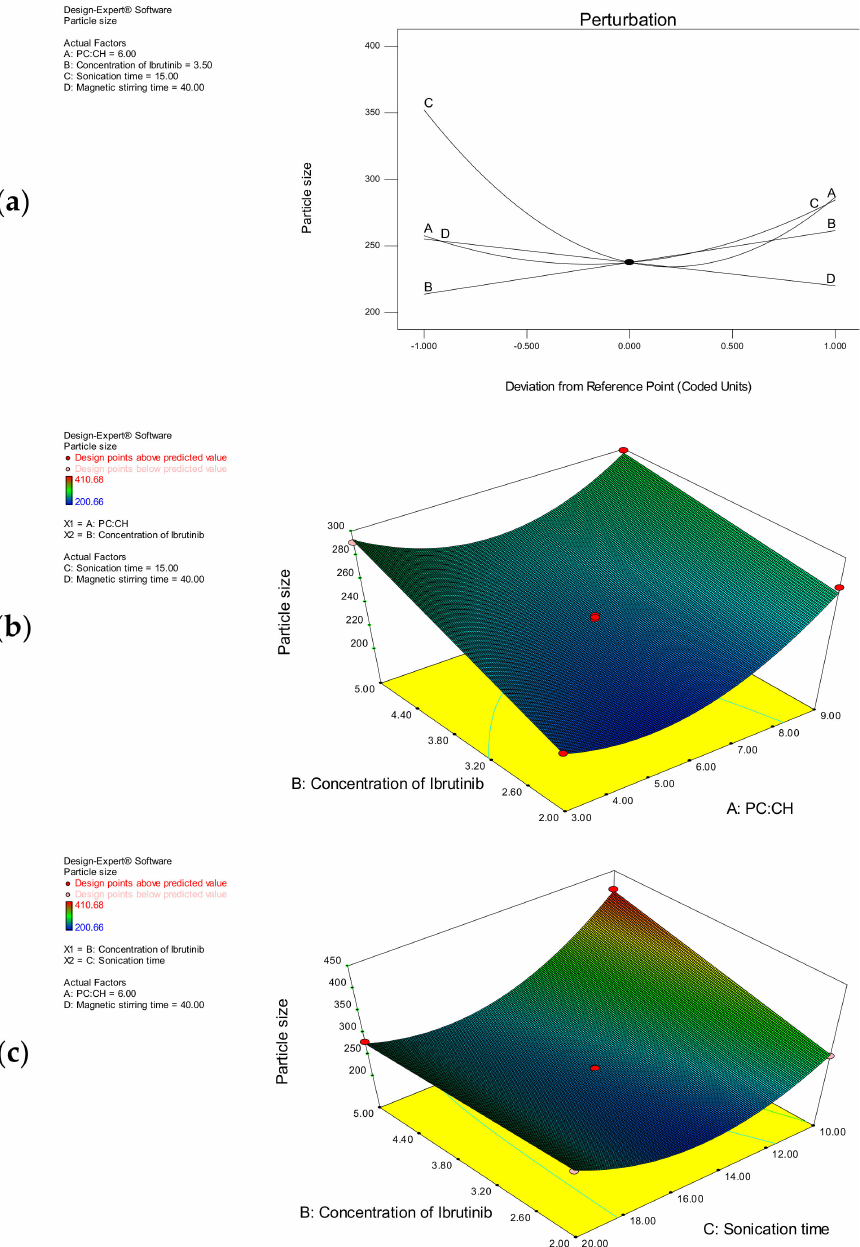
Figure 3. ( a ) Two – dimensional perturbation plot showing the effects of A, B, C, and D on the particle size; ( b ) 3D response surface plot showing the interactive effect of A and B on the particle size at constant levels of C and D; ( c ) 3D response surface plot showing the interactive effect of B and C on the particle size at constant levels of A and